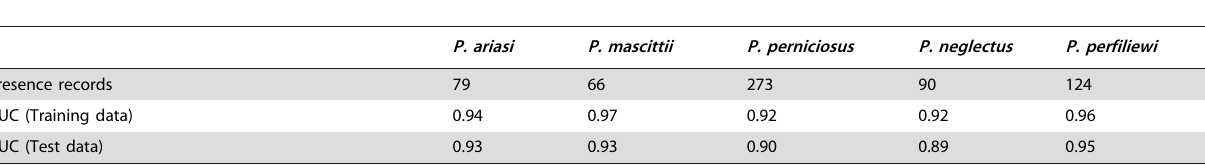
Table 1. Number of species presence records, AUC-values, and training gain for the selected bioclimatic